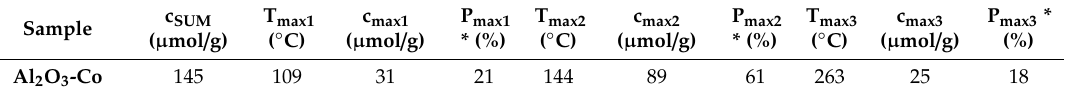
Table A3. Basicity of cobalt catalyst determined by CO 2 TPD.